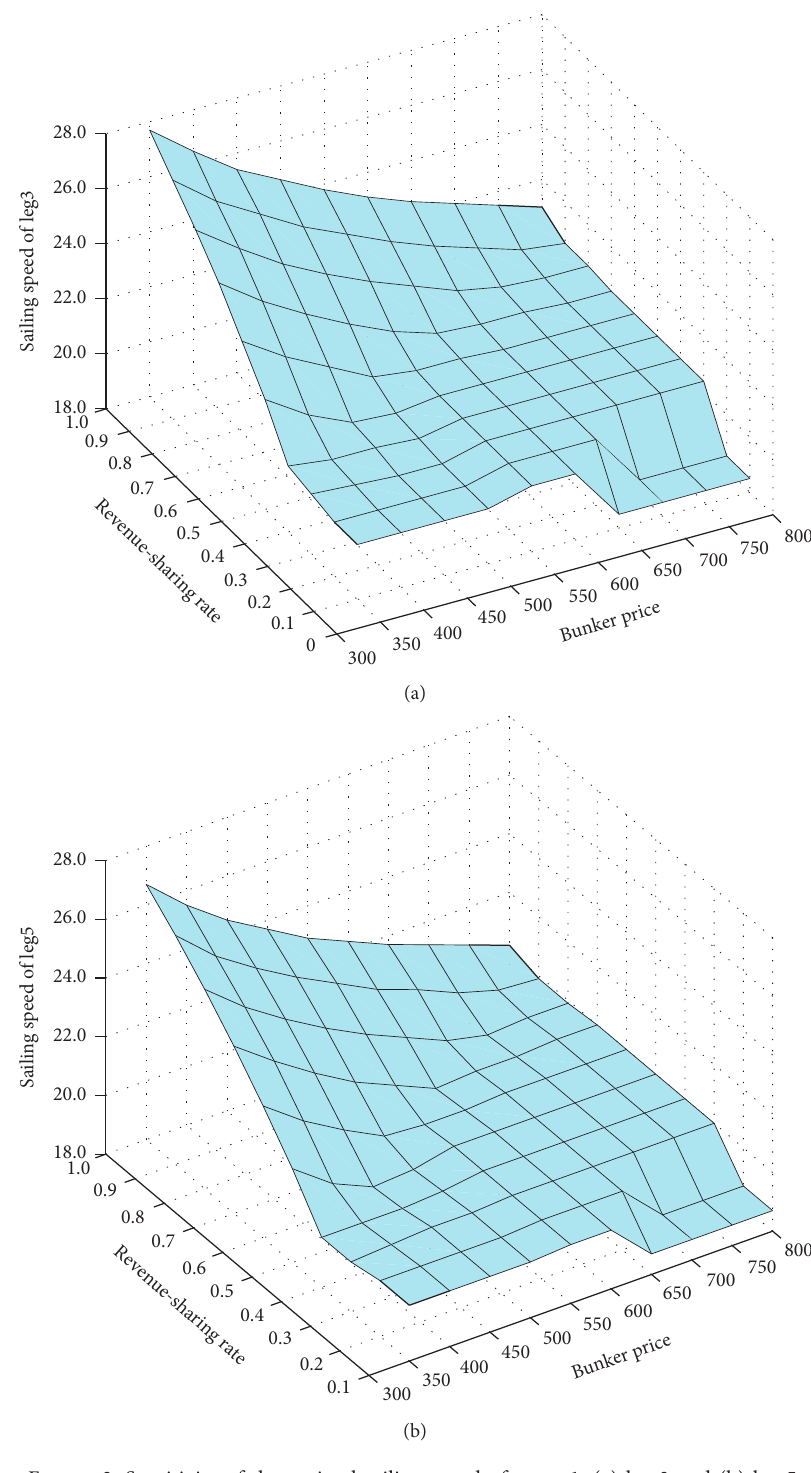
Figure 2: Sensitivity of the optimal sailing speed of route 1: (a) leg 3 and (b) leg